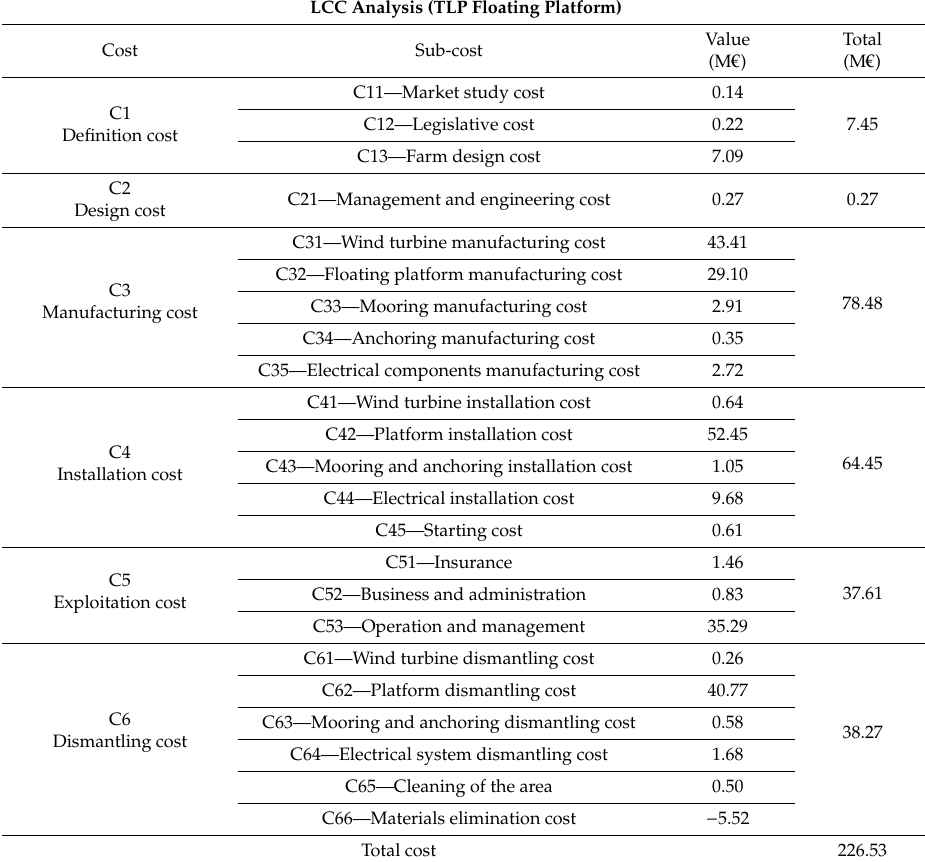
Table 4. LCC analysis for floating o ff shore wind farm (FOWF) with the TLP platform. LCC Analysis (TLP Floating